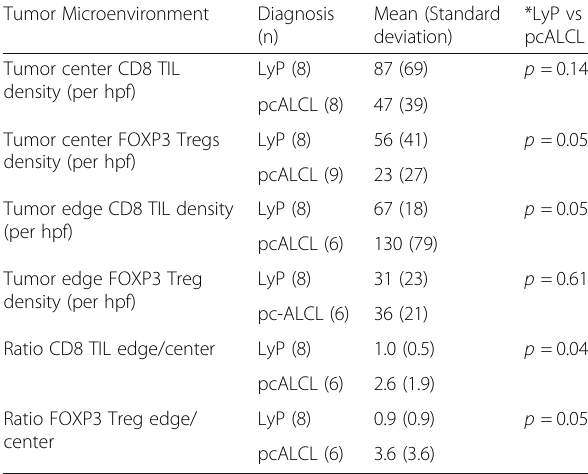
Table 2 Tumor microenvironment analysis: Comparing average FOXP3 Treg and CD8 TIL density at the center or edge of tumor lesions Tumor Microenvironment Diagnosis